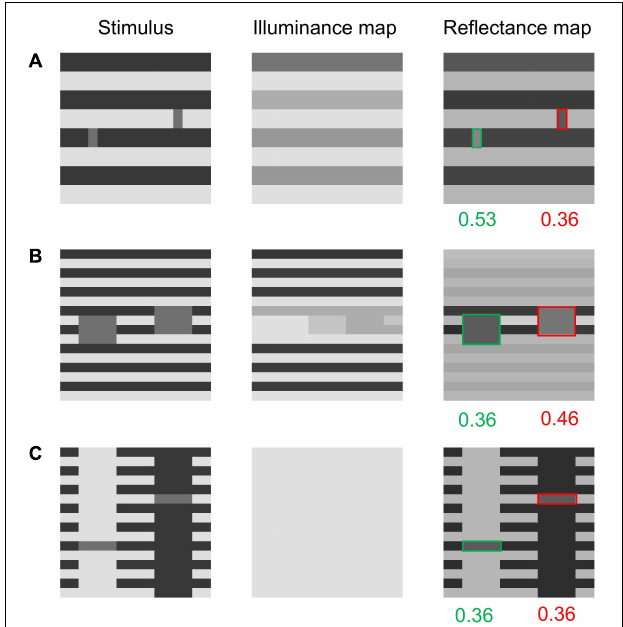
FIGURE 8 | Some variants of the White-effect figure and the modified model’s outputs for them. (A) A White-effect figure variant with narrow targets. The model correctly predicts illusion enhancement (i.e., a stronger effect than in the original White-effect figure). (B) A White-effect figure with taller targets. The model predicts a reversal of the effect. (C) Howe (2001)’s variant. The modified model correctly predicts no